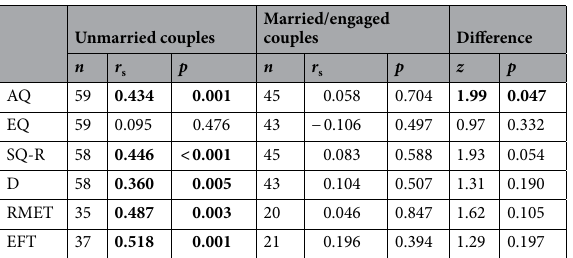
Table 2. Within-couple correlations for autism-related variables stratified by marital status. AQ, Autism Spectrum Quotient; EQ, Empathy Quotient; SQ-R, Systemizing Quotient-Revised; D, difference in standardized EQ (E) and SQ-R (S) scores; RMET, Reading the Mind in the Eyes Test; EFT, Embedded Figures Task. Effects in bold are statistically significant at the conventional threshold of p < 0.05 (two-tailed). Average difference of all Actual couple difference other